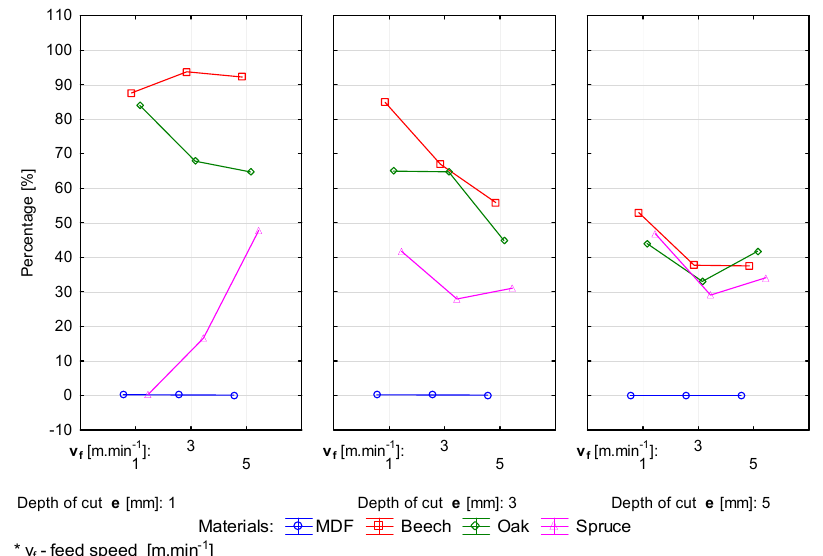
Figure 2. Grain size grade 2 mm.